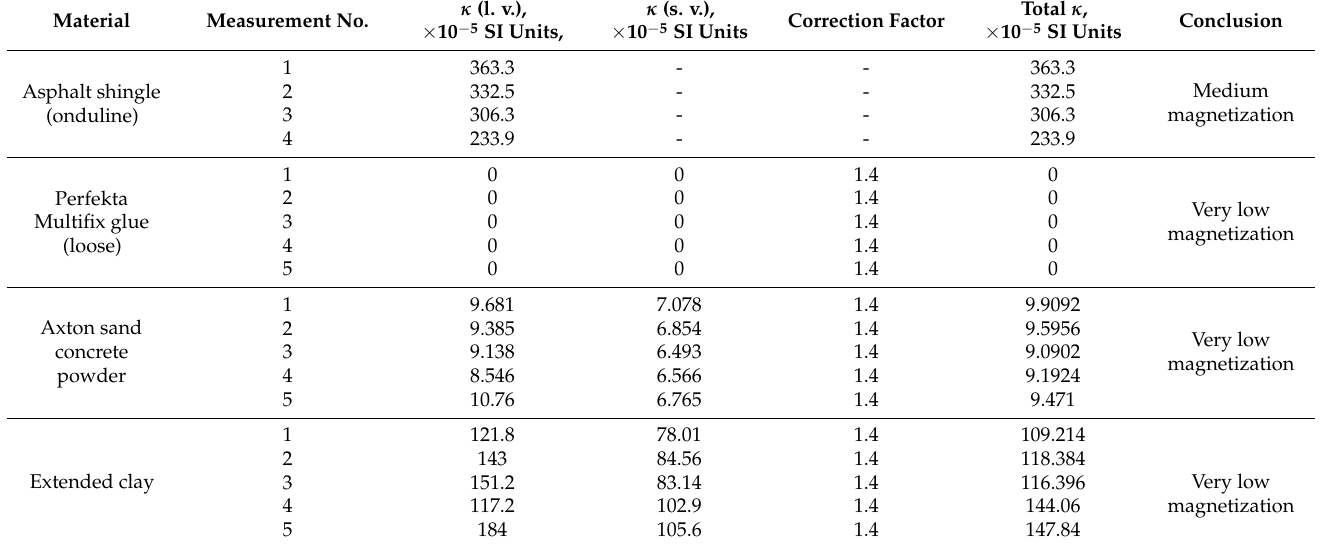
Table 3. Magnetic susceptibility of materials used for construction of a pavilion and a pillar at the White Sea